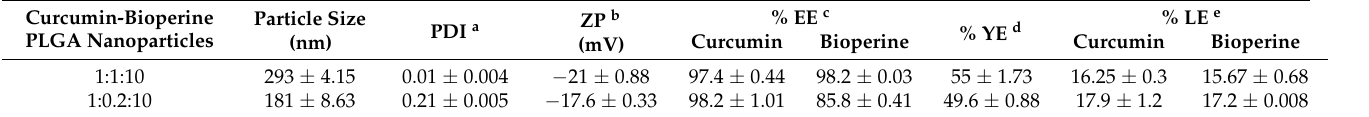
Table 1. Physico–chemical characterizations of curcumin-Bioperine PLGA Nanoparticles. Curcumin-Bioperine PLGA